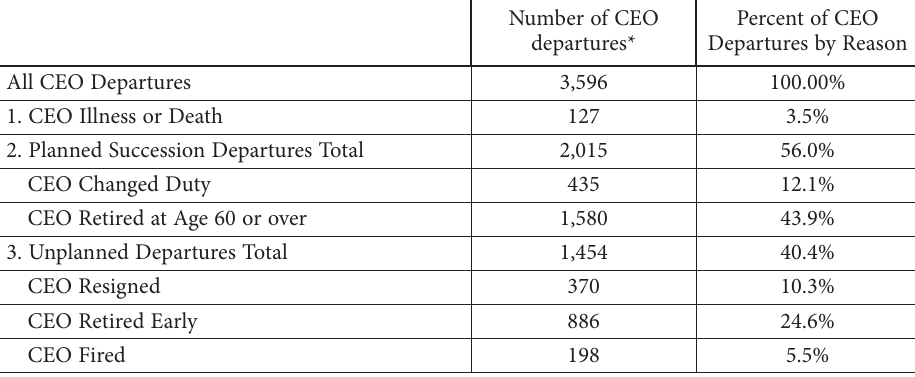
Table 2. CEO departure types in the data